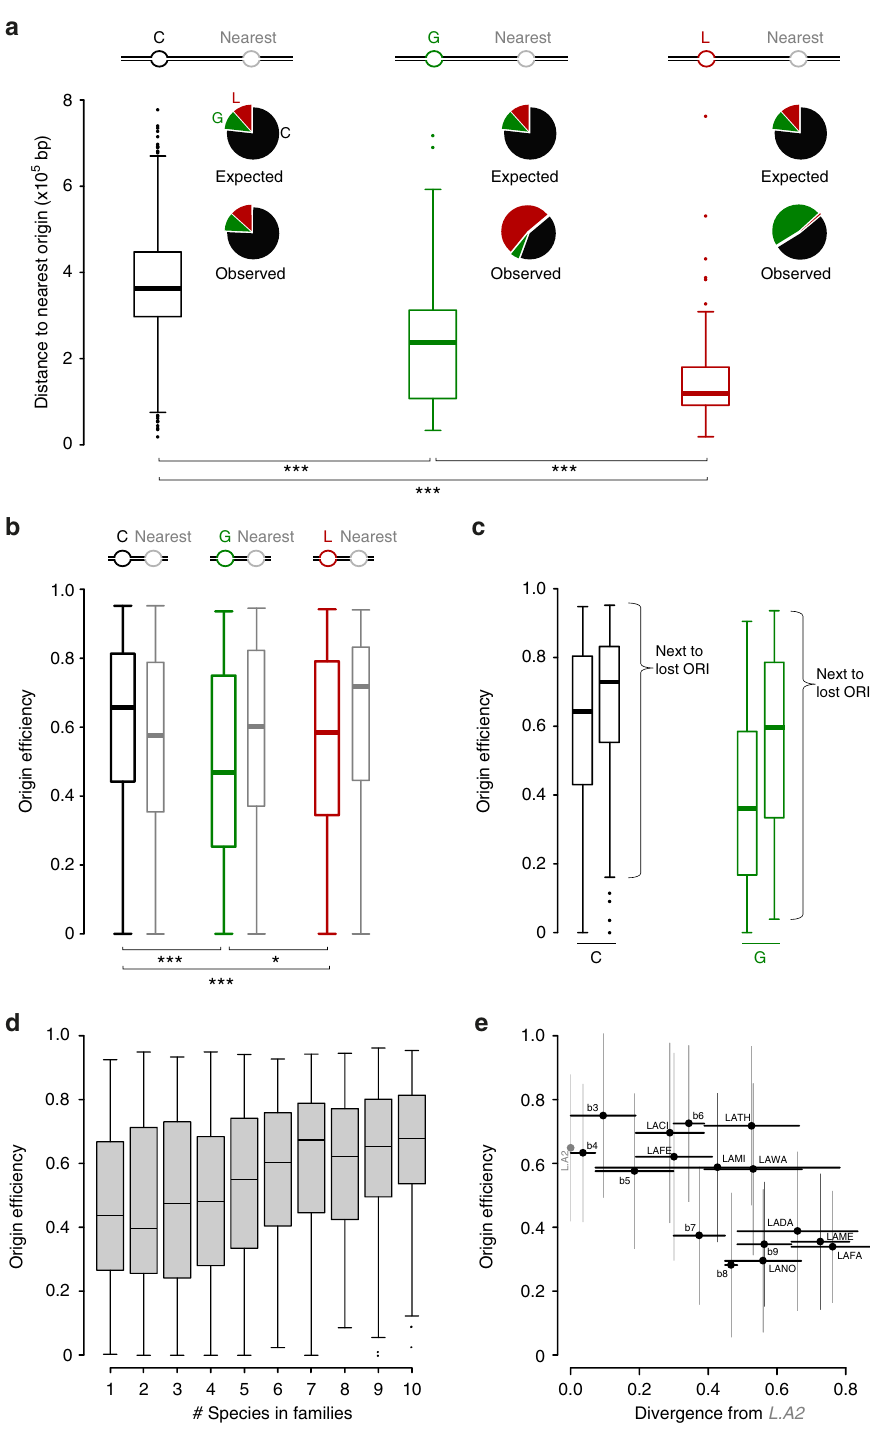
gains since the nine Lachancea species diverged from L .